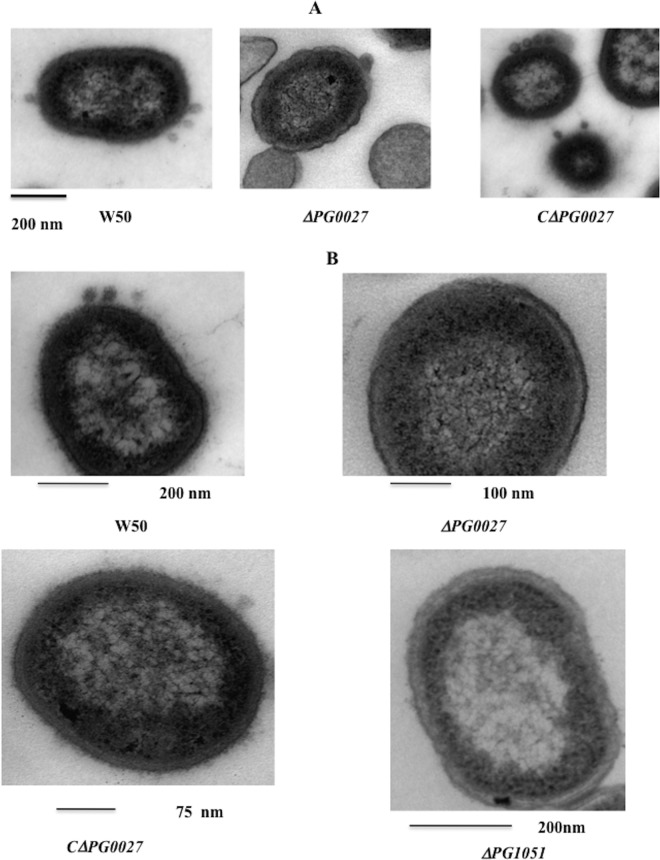
TEM of P. gingivalis W50, the ΔPG0027 and ΔPG1051 (waaL) mutant strains, and the CΔPG0027 strain. Samples were prepared for TEM as described in Materials and Methods. (A) The scale bar represents 200 nm. OMV formation in P. gingivalis W50 and the CΔPG0027 strain is clearly visible as defined structures. (B) Close-up view of the outer surface layers of P. gingivalis W50, the ΔPG0027 and ΔPG1051 (waaL) mutant strains, and the CΔPG0027 strain.